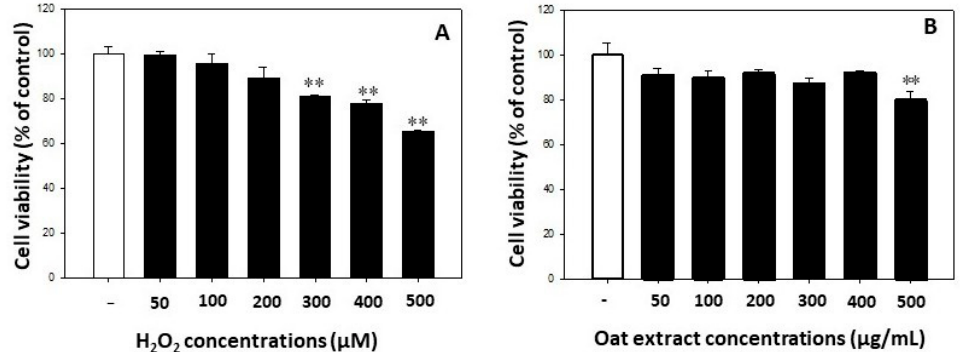
Figure 2. Effect of hydrogen peroxide ( A ) and oat 80% ethanol extract ( B ) on cell viabilities. Human keratinocyte HeCaT cells were treated with hydrogen peroxide or oat ( Avena sativa, cv. Daeyang) 80% ethanol extract for 24 h followed by MTT assay to determine cell viabilities. Data are expressed as mean ± SD. ** p < 0.01 vs. vehicle-treated cells.